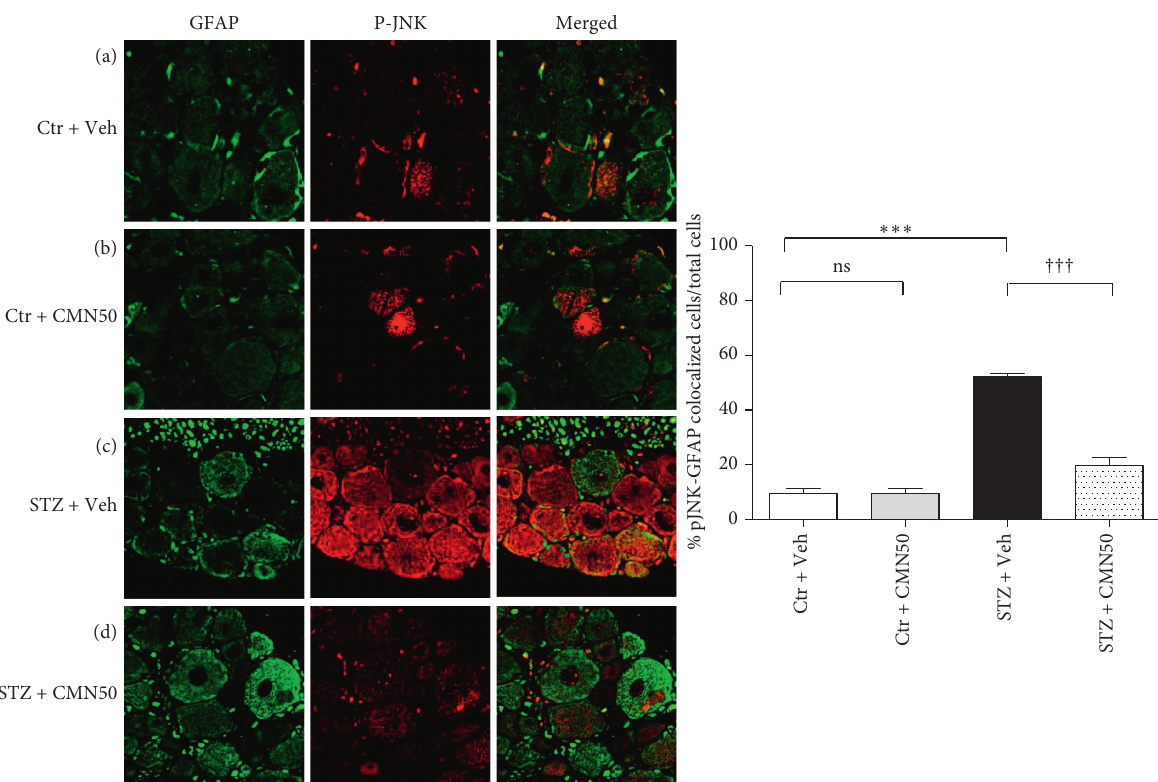
Figure 4: Immunohistochemistry for pJNK (red, pJNK antibody) expression in the astrocytes of the dorsal root ganglion (DRG) (green, GFAP antibody). Treatment of streptozotocin- (STZ-) induced diabetic neuropathic pain rats (STZ+CMN50) with 50mg/kg/day of curcumin (CMN) for 4 consecutive weeks normalized pJNK expression in the astrocyte of the DRG. (a) Control group (Ctr+Veh, n � 4); (b) curcumin-treated control group (Ctr+CMN50, n � 4); (c) STZ-induced diabetic neuropathic pain rats (STZ+Veh, n � 4); (d) curcumin- treated STZ-induced diabetic neuropathic pain rats (STZ+CMN50, n � 4). ∗∗∗ p < 0 . 001 compared to the Ctr +Veh group; ††† p < 0 . 001 compared to the STZ+Veh group.